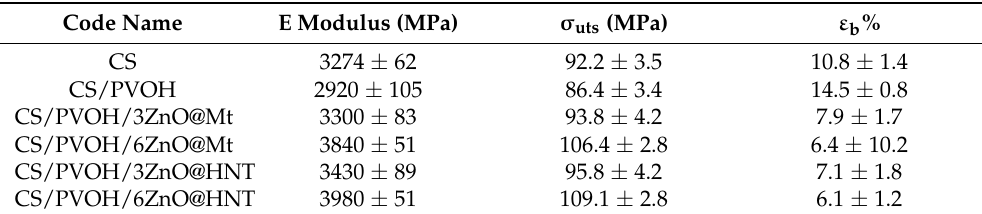
reported in our previous work [26].